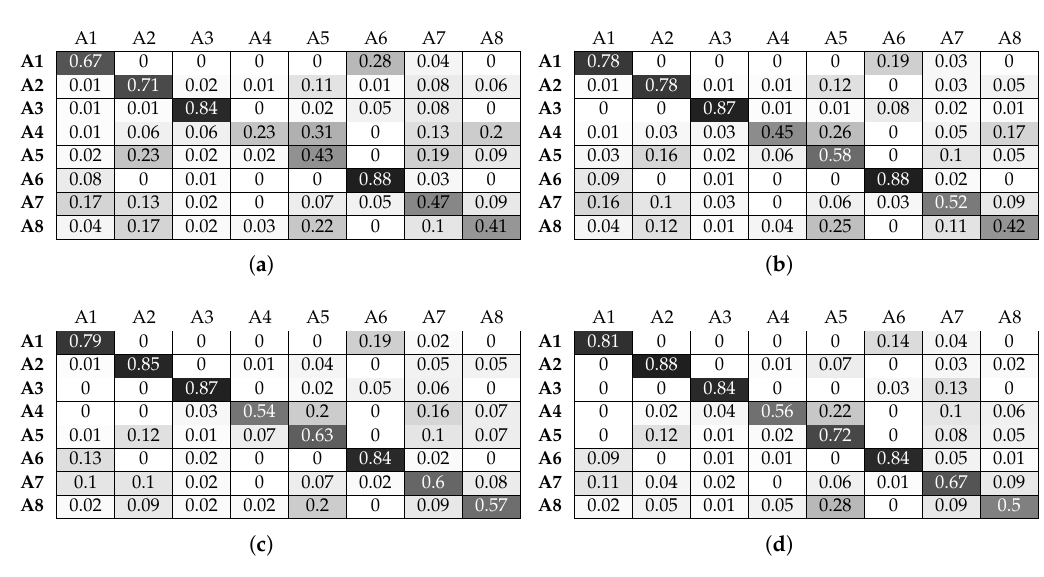
Figure 10. Normalised confusion matrices for logistic regression, with Wearable Feature Type 2, without beacon data. ( a ) C = 10, w = 1 s; ( b ) C = 100, w = 2 s ; ( c ) C = 10, w = 3 s; ( d ) C = 10, w = 4 s.